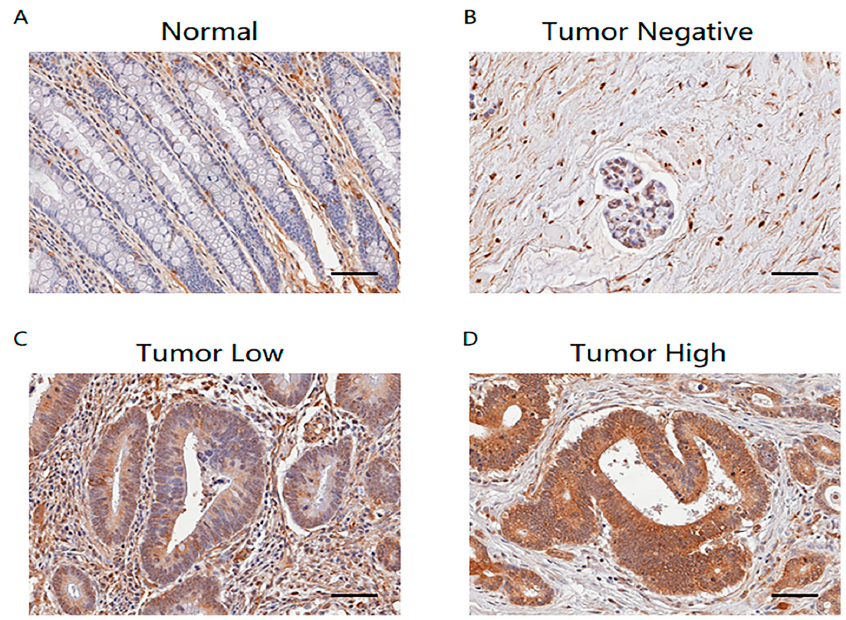
Figure 6. Confirmation of TSPAN5 expression in colon cancer tissue. ( A ) No expression in normal tissue. ( B ) No expression in colon cancer tissue. ( C ) Low expression in colon cancer tissue. ( D ) High expression in colon cancer tissue (Scale bar: 100 μ m). Table 1. Relationship between chi-square values for TSPAN5 expression and the clinicopathological factors of colorectal